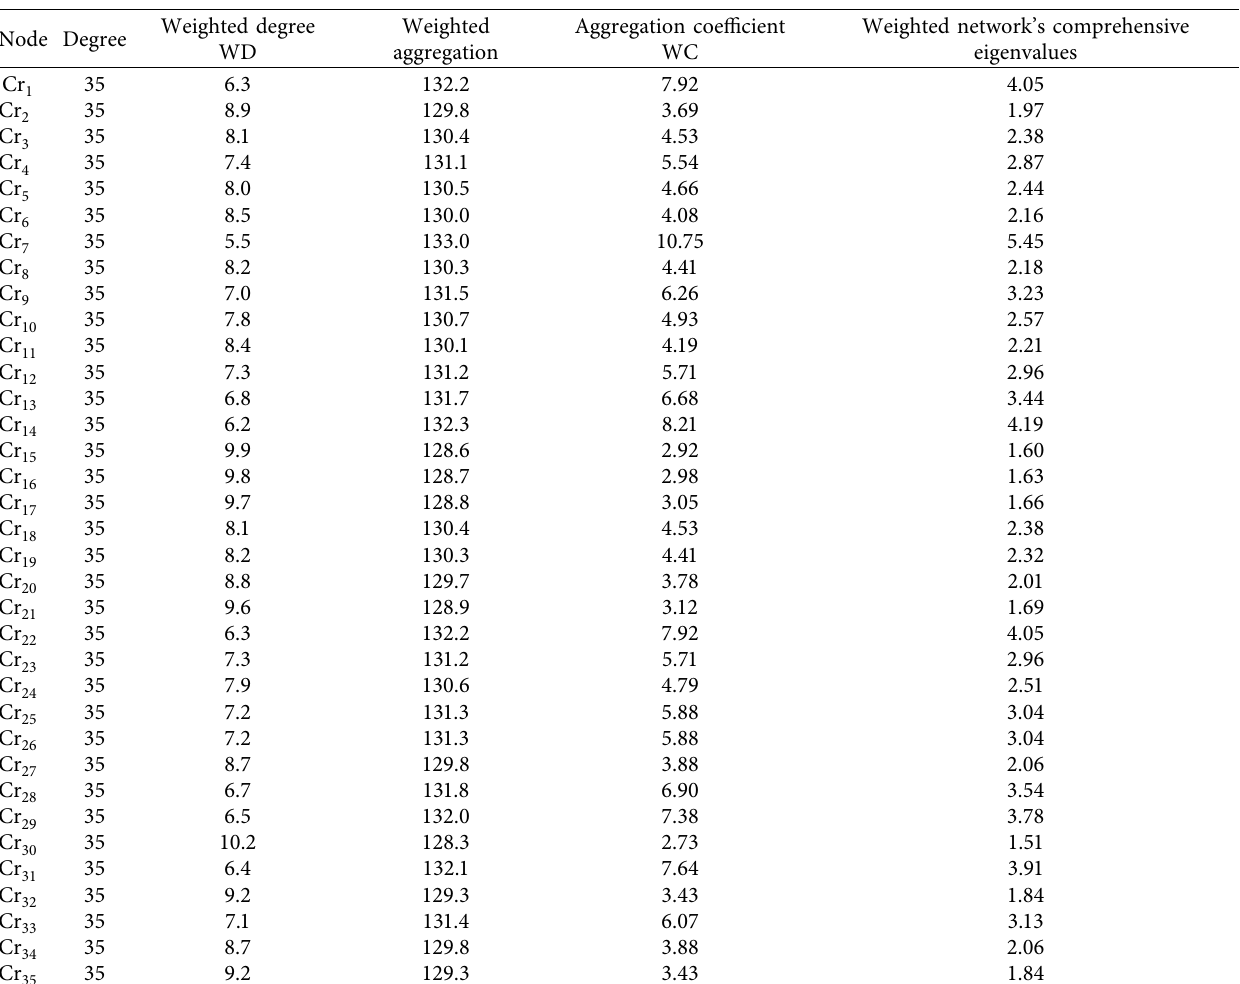
Figure 4: Undirected weighted network model of customer demands. Table 4: Eigenvalues of the weighted network